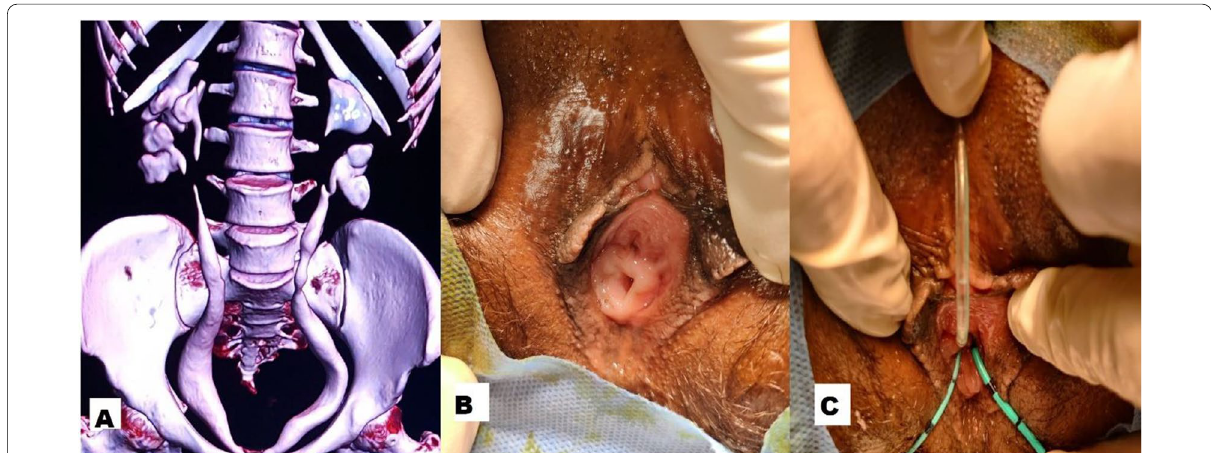
Fig. 1 A 3D reconstructed CT showing bilateral duplex collecting system with ectopic ureter. 3D, three-dimensional, B Urethral and vaginal orifices, C Ectopic ureteral orifices cannulated with ureteric catheters